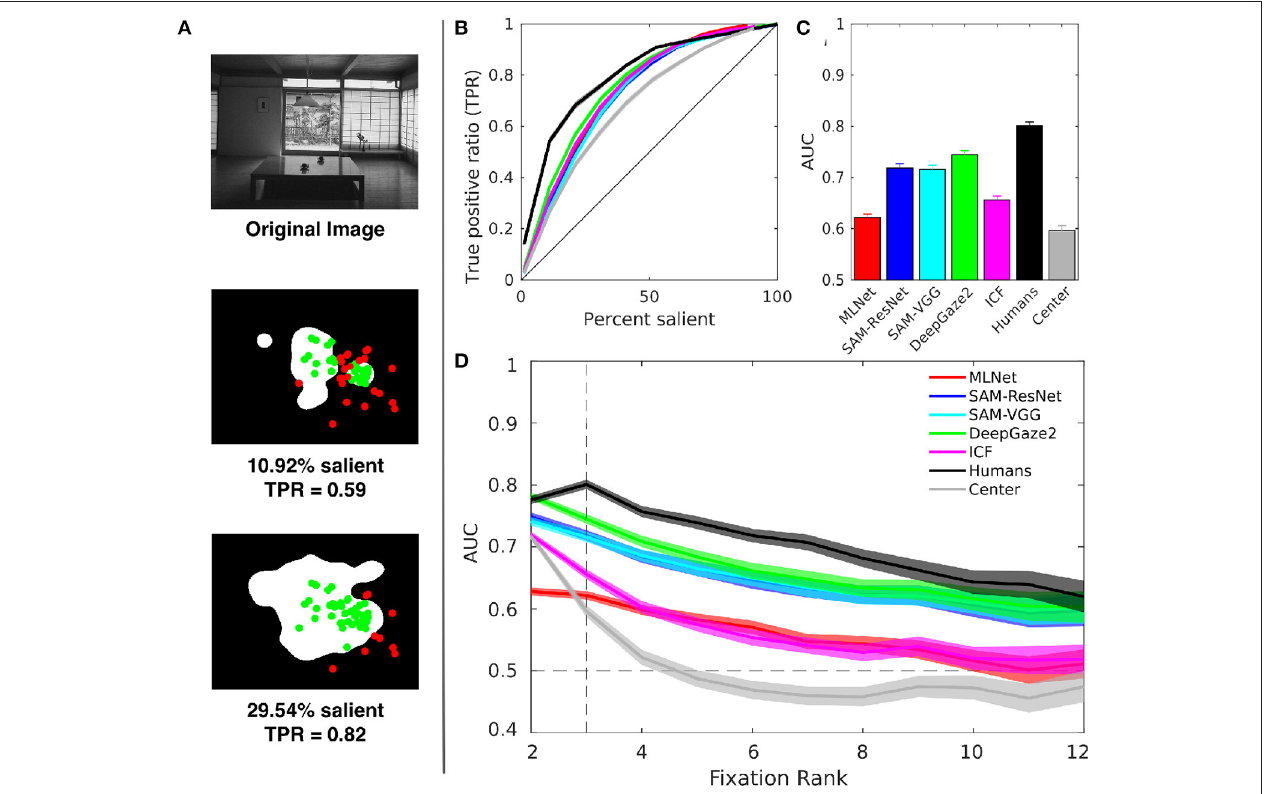
FIGURE 3 | Saliency maps. We compare the results of five state-of-the-art models: DeepGazeII, ICF (Kummerer et al., 2017), SAM(ResNet-50 and VGG-16 versions) ( Cornia et al., 2018), and MLNet (Cornia et al., 2016), and two controls: a center bias (2D centered Gaussian) and an empirical third-fixation subjects saliency map (humans). (A) Example of how to estimate the TPR for the ROC curve, (B) ROC curves, (C) AUC-Borji values for the third fixation, and (D) AUC for each model as a function of the current Fixation Rank. Color mapping for models is consistent for (B–D)